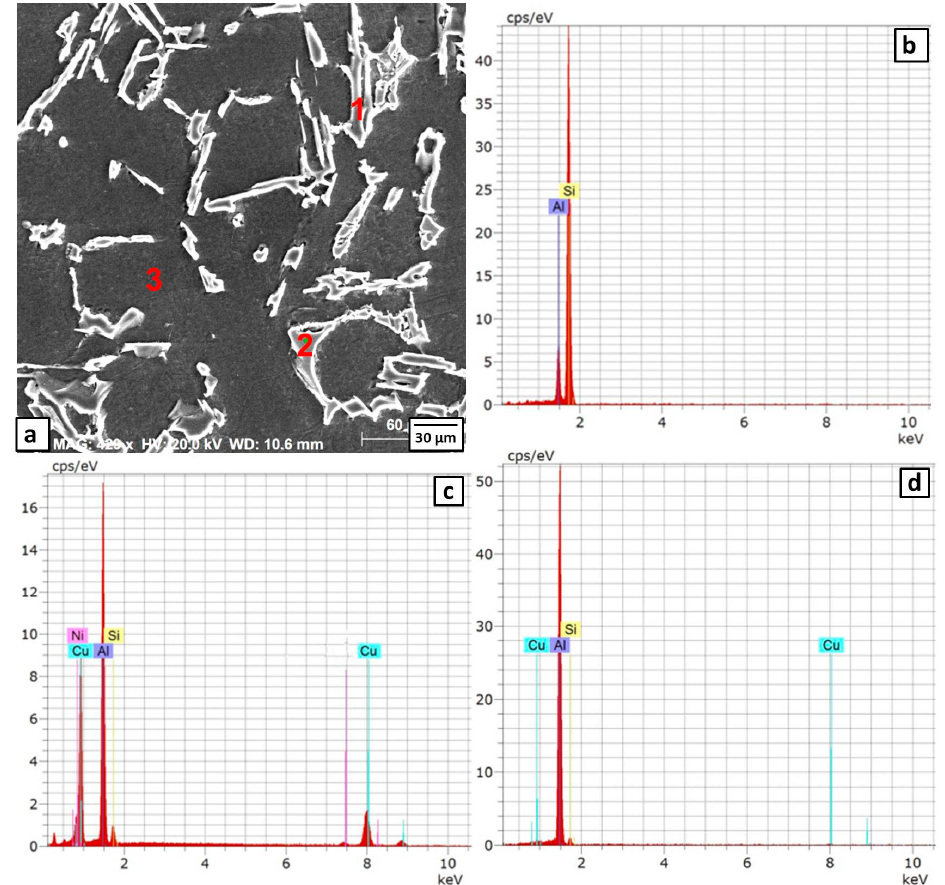
Figure 8. Enlarged SEM image ( a ) of the formed composite of 6% Cu after the heat treatment at 380 °C for 6 h and the EDS spectra of Point 1 ( b ); Point 2 ( c ) and Point 3 ( d ).